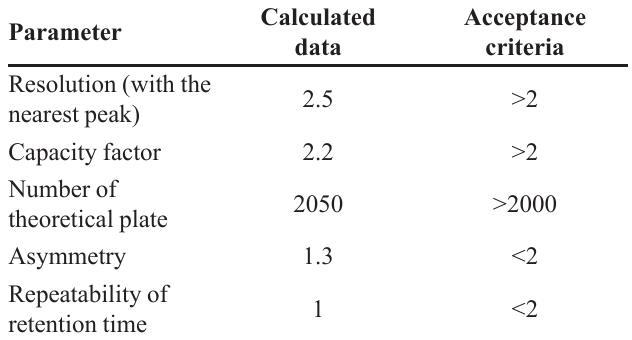
TABLE III - Accuracy and precision data of the proposed EME-